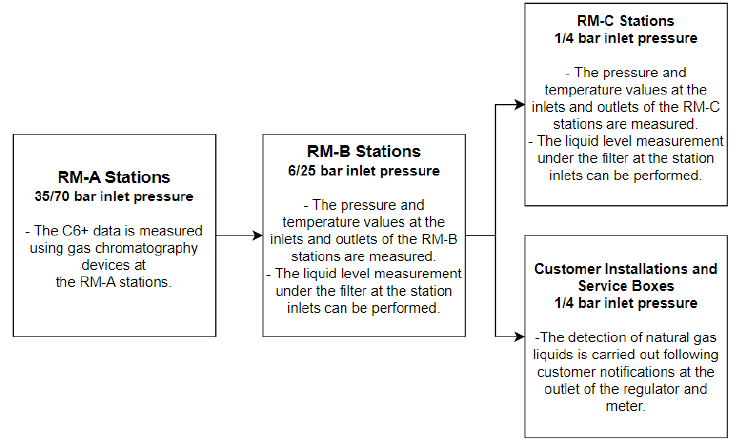
Figure 3. Sampling and measurement points of the natural gas network.